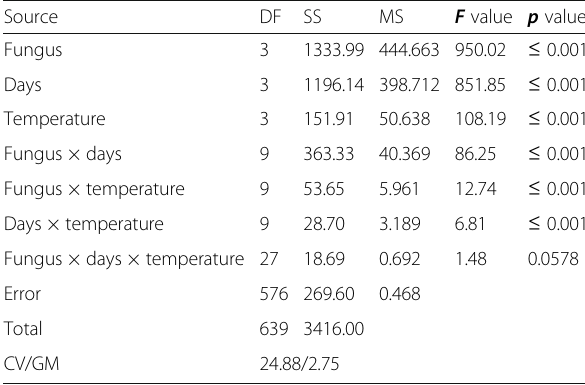
Table 4 Factorial analysis of variance of mortality of Bemisia tabaci bioassayed with the binary combinations (conidia